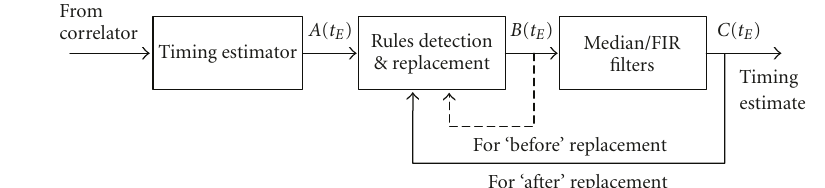
Figure 10: Block diagram for rule processing.